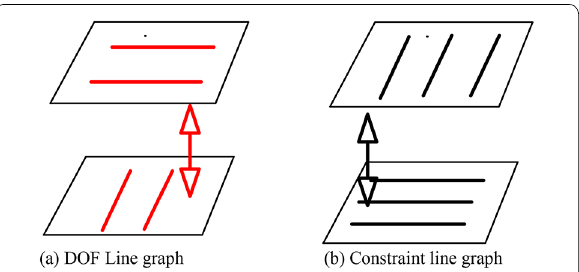
Figure 10 F&C line diagram of the second 2R1T mechanism